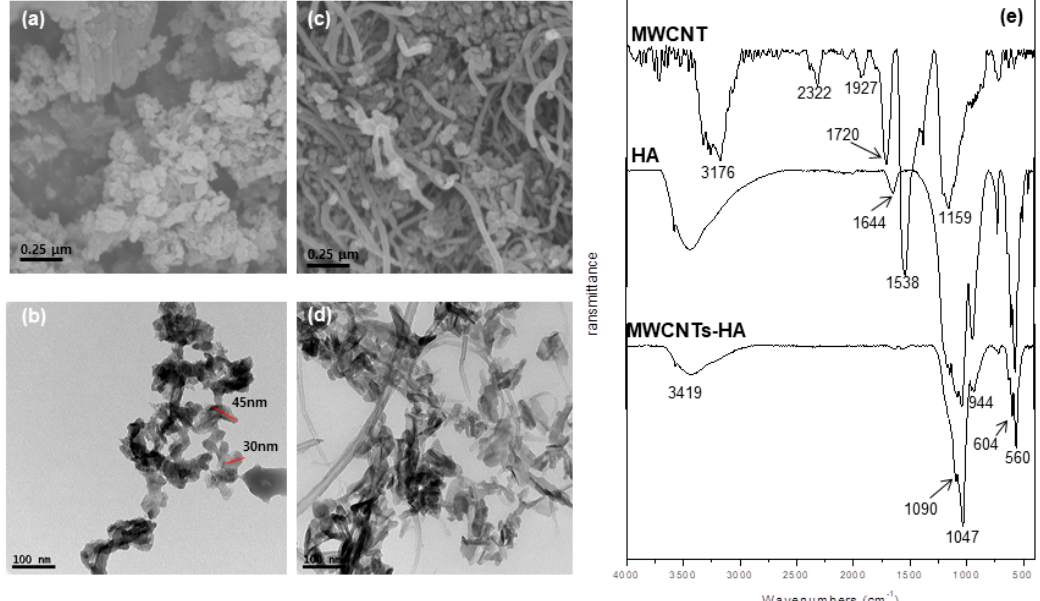
Figure 1. ( a ) Field emission scanning electron microscope (FE-SEM) and ( b ) transmission electron microscopy (TEM) image of sol-gel synthesized hydroxyapatite (HA) powders, ( c ) FE-SEM image and ( d ) TEM image of multi walled carbon nanotubes-hydroxyapatite (MWCNTs-HA) powders, and ( e ) Fourier-transform infrared spectroscopy (FT-IR) spectra of MWCNT, HA and MWCNTs-HA powders.